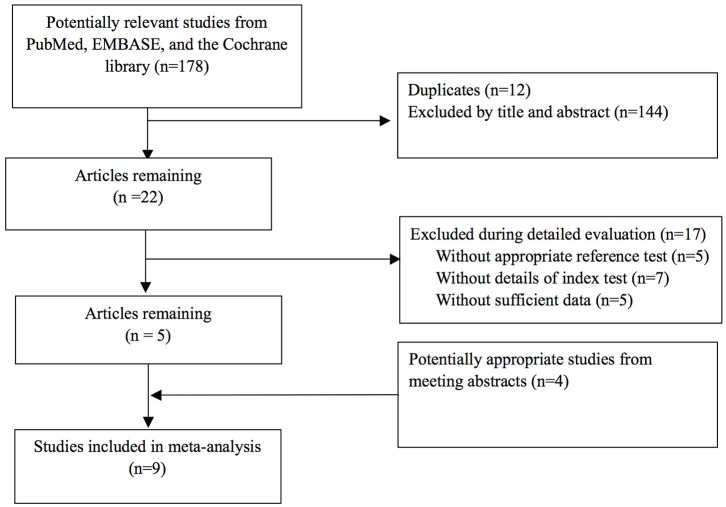
Flow diagram of the systematic search and selection process of studies.